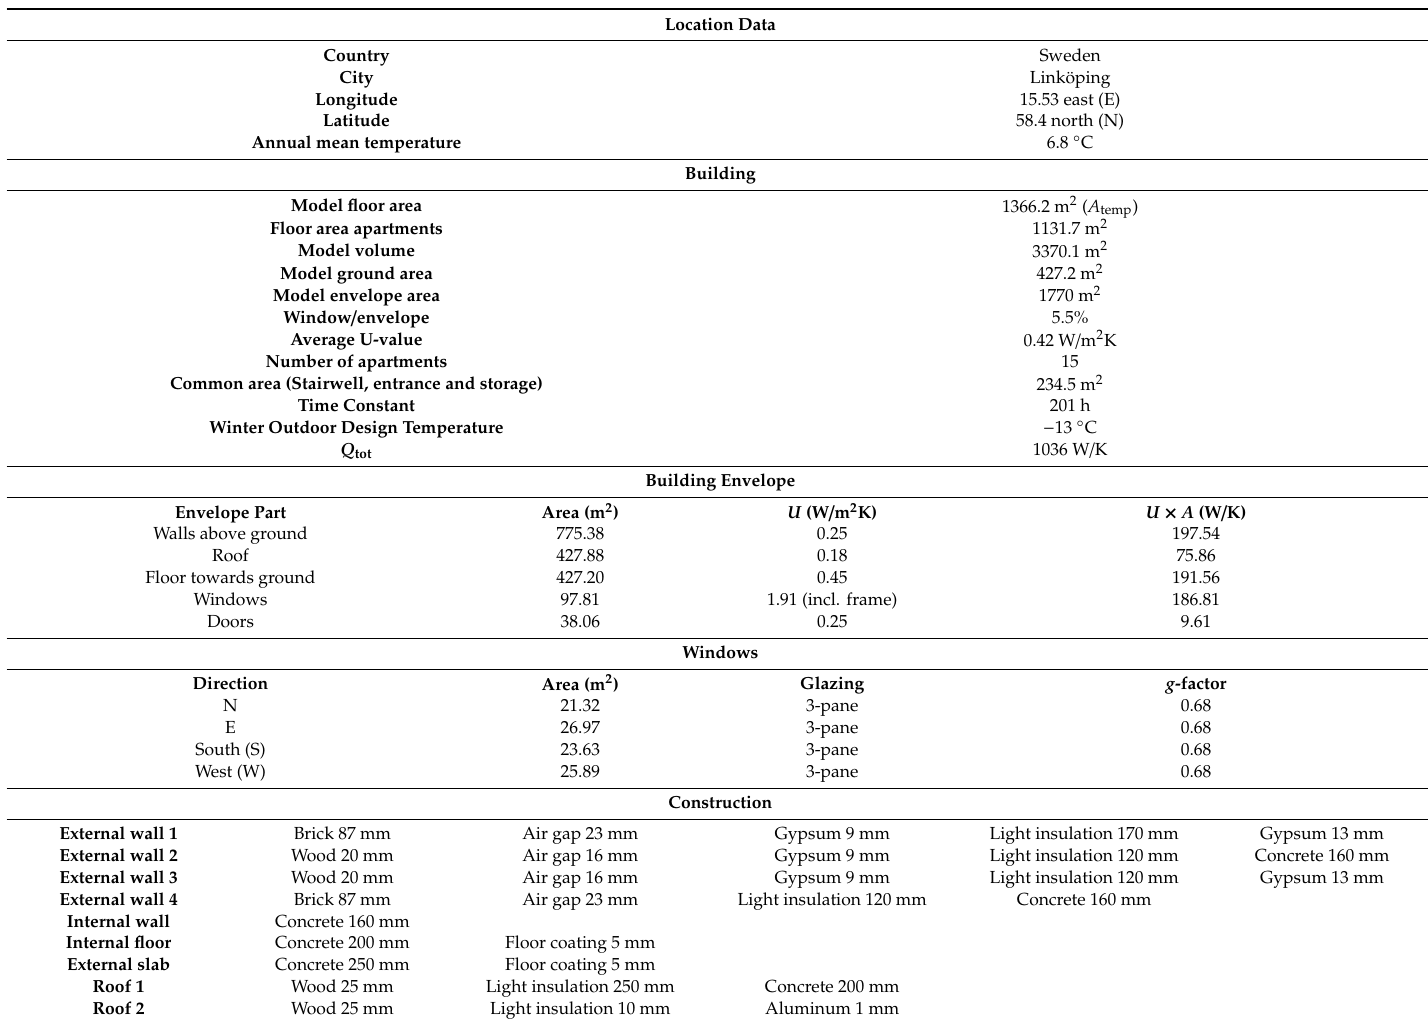
Table 2. Technical data of the modeled